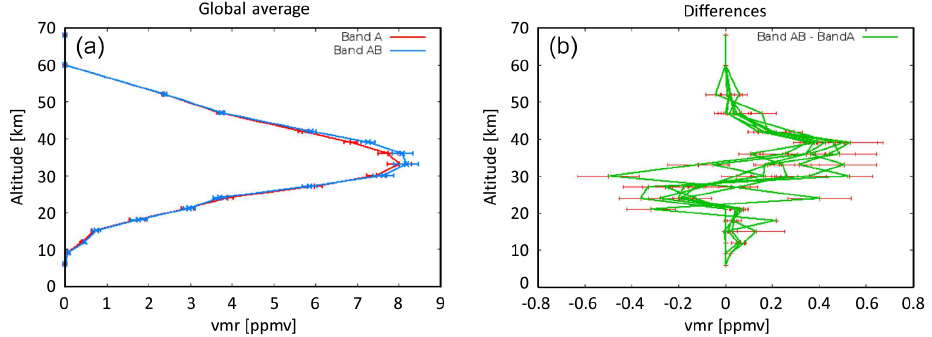
Figure 2. (a) Mean ozone profiles of MIPAS orbits 2633 and 2634 retrieved with the Bologna geo-fit multitarget retrieval model (GMTR) using microwindows in MIPAS channels A (red) and AB (blue). (b) Respective AB–A differences for several latitude bands.